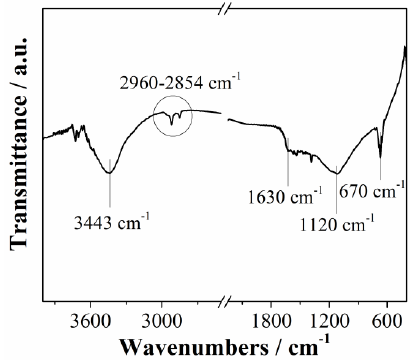
Figure 3. FTIR spectrum of Mn 3 O 4 @N-doped carbon.